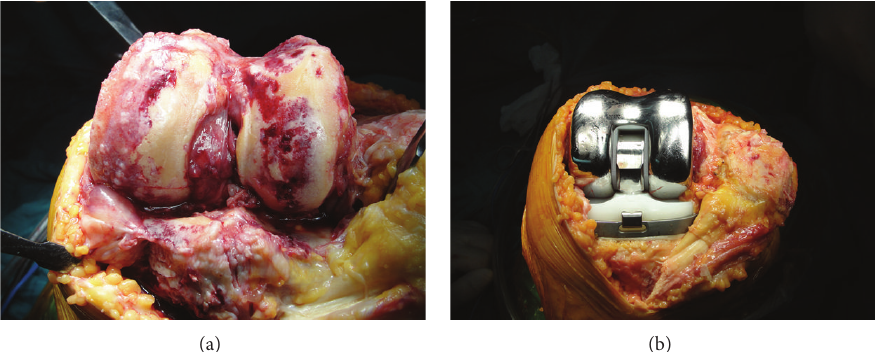
Figure 5: Degenerative arthritis and torn cruciate ligaments were seen and a rotating hinged knee prosthesis was applied.